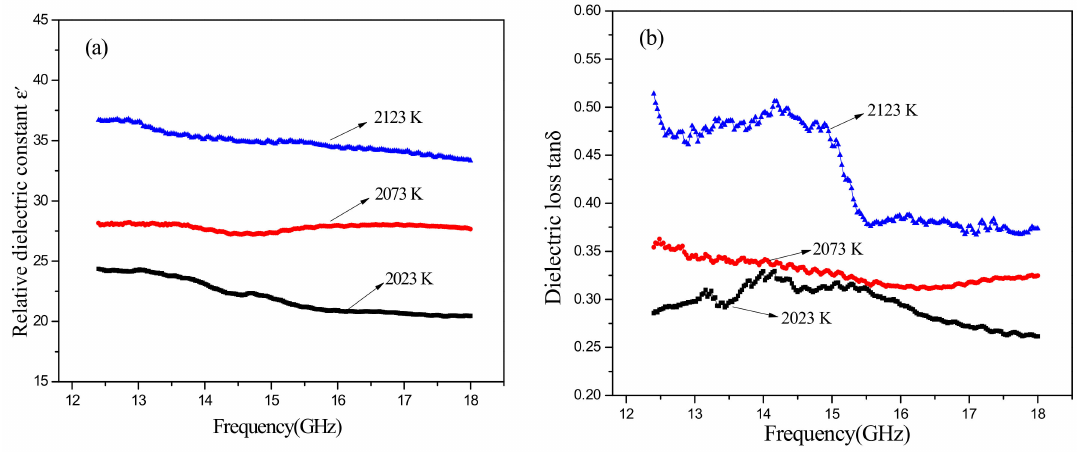
Figure 7. Dielectric properties of SiC-AlN ceramics with different sintering temperature at high frequencies: ( a ) relative dielectric constant; ( b ) dielectric